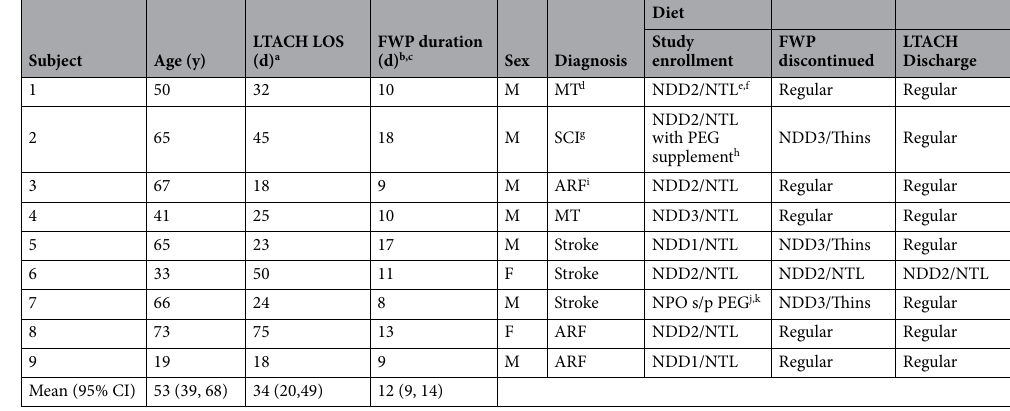
Table 2. Participant characteristics. a LTACH long-term acute care hospital; c FWP free water protocol; d